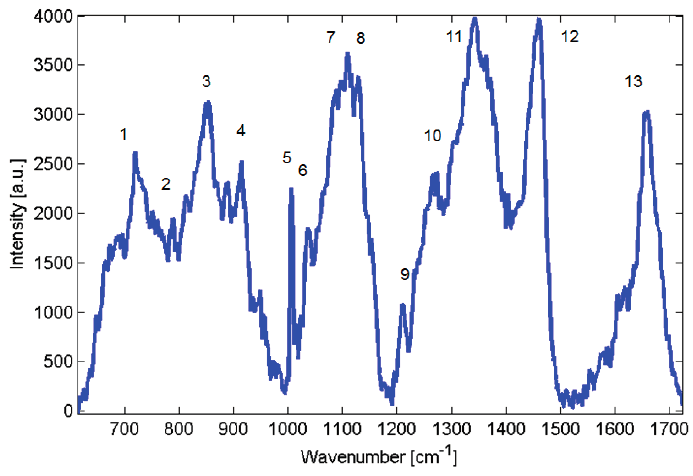
Figure 2. Raman spectra of Candida